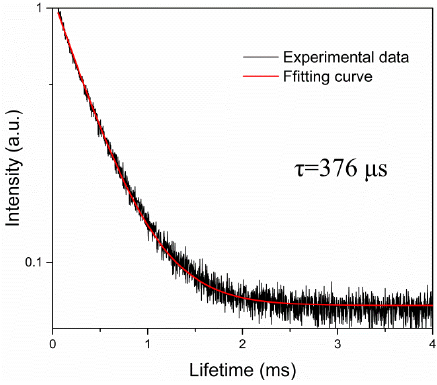
Figure 2. Room temperature fluorescence decay curve of the 4F 3/2 manifold of the Nd:ASL crystal.